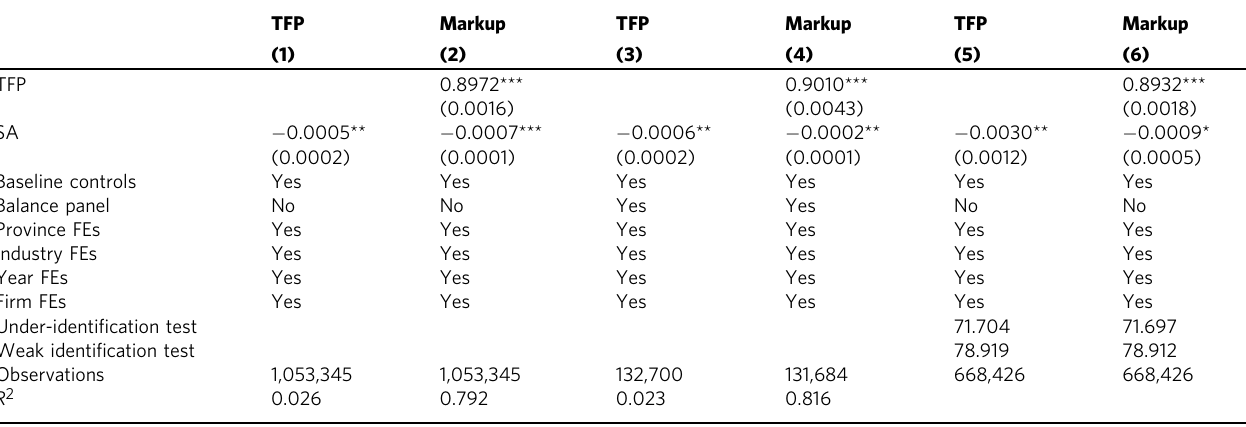
Table 9 In fl uence mechanism